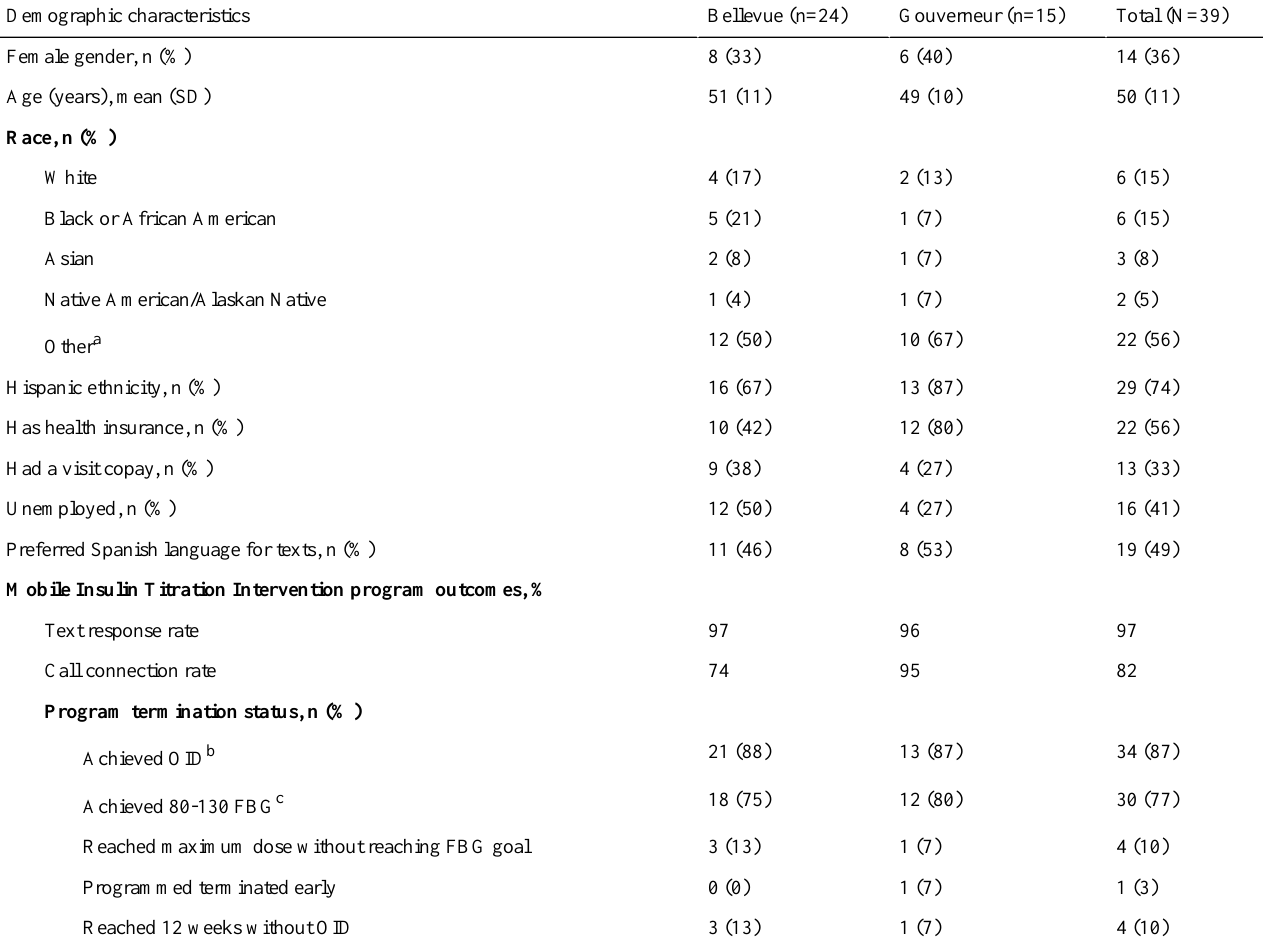
Table 1. Characteristics and Mobile Insulin Titration Intervention program outcomes of the patient interview